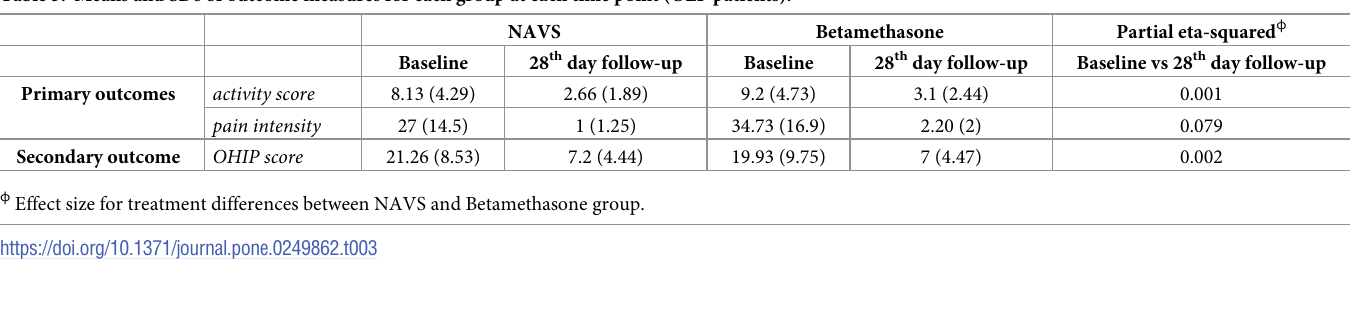
Table 3. Means and SDs of outcome measures for each group at each time point (OLP patients).